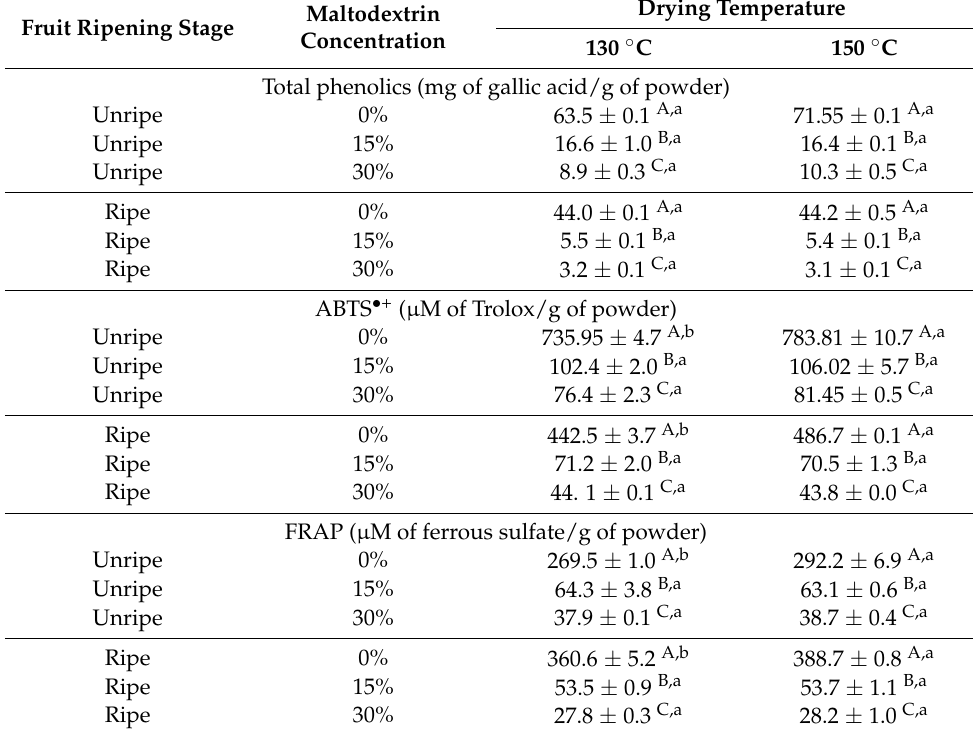
Table 3. Total phenolic content and antioxidant activity of spray-dried powders of pure papaya seed extracts and those with maltodextrin as a carrier